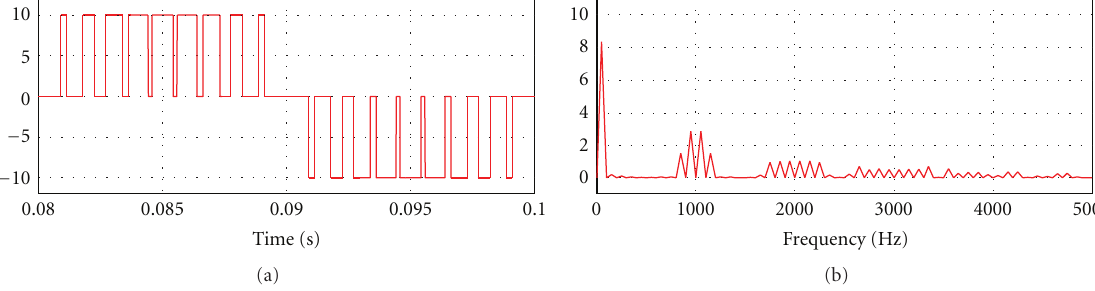
Figure 9: PWM output current waveform i inv and harmonic content of the proposed circuit operating at m pv = m wind , I pv = I wind , f line = 50Hz, and f sw = 1kHz.